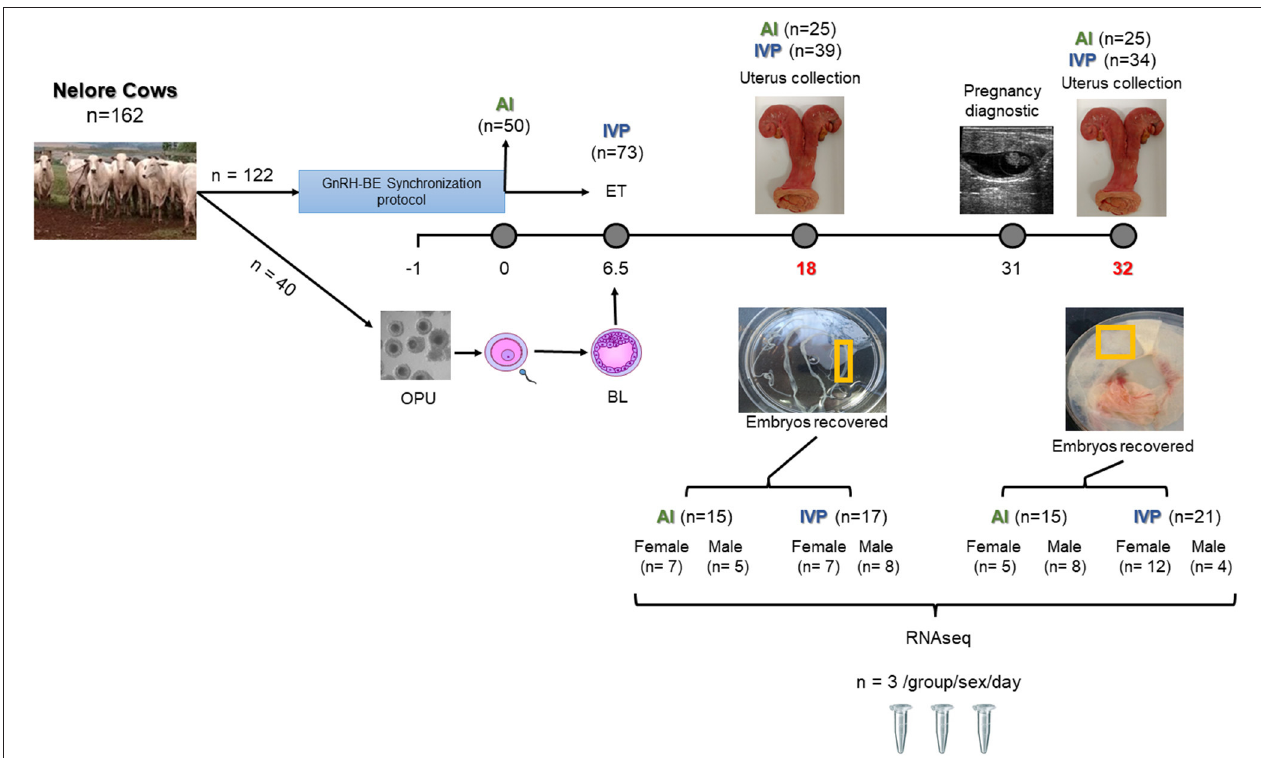
FIGURE 1 | Experimental design. Donors were aspirated (OPU) on day-1. On day 0, was the day of insemination (AI) for AI group. After 6.5 days, IVP group, received an embryo transfer (ET). On day 18, half of the animals from each group had the uterus collected. On day 32, cows confirmed pregnant were collected. A fragment of the conceptuses recovered on day 18 and placentas on day 32 days were collected and snap frozen for posterior RNA/DNA